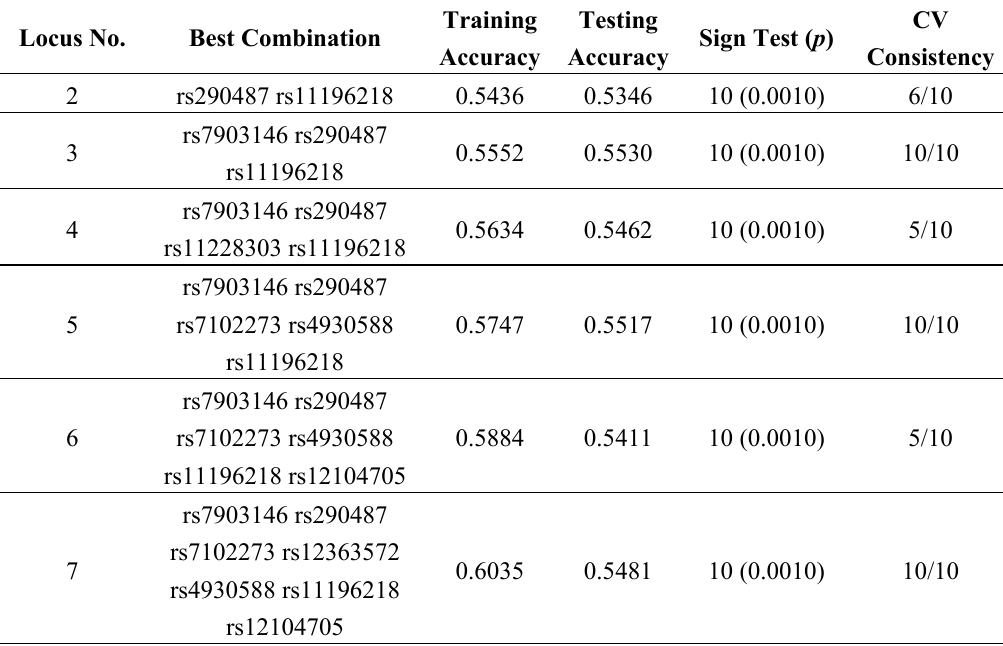
Table 10. Best gene-gene interaction models identified by the MDR v1.2.0. Locus